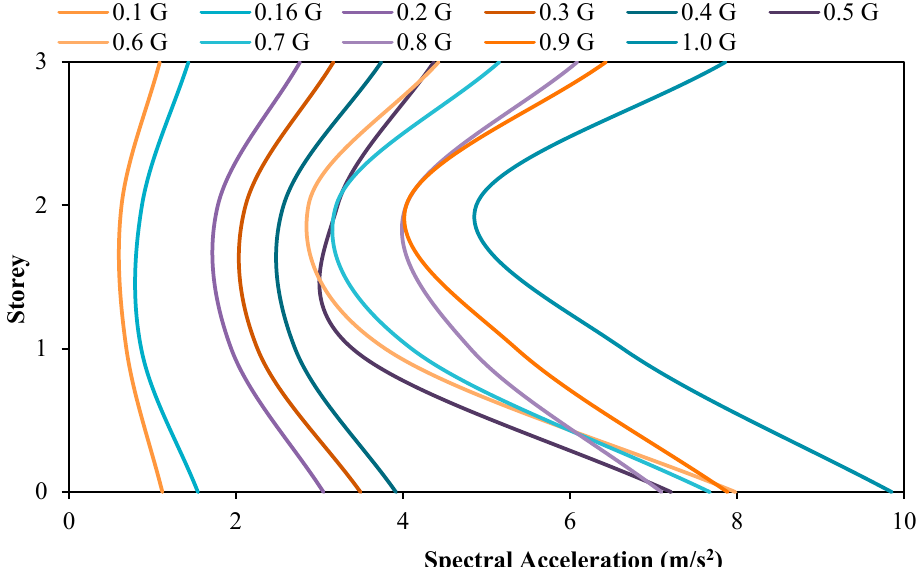
Figure 7. Spectral acceleration of structure without dampers.